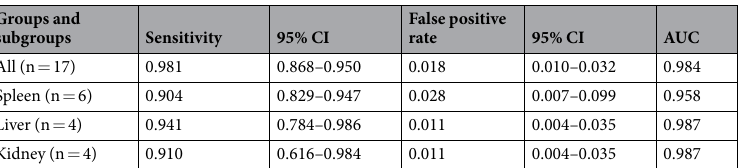
Table 4. Diagnostic performance of CEUS using computed tomography as reference standard. Statistics were pooled using bivariate model. The n value in the first column was the number of datasets available for combination, and thus one study could provide more than one